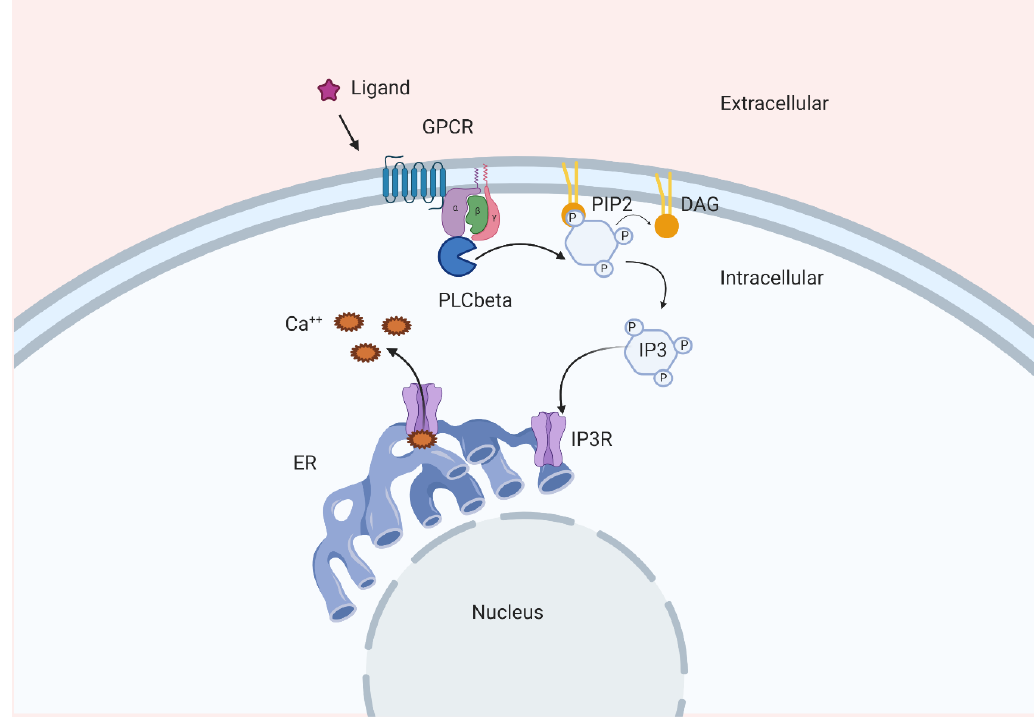
Figure 2. Schematic representation of one of the pathways involved in Ins(1,4,5)P 3 -dependent Ca 2+ release. GPCR, G protein-coupled receptor; IP3, Ins(1,4,5) P 3 ; Ca ++ , calcium; ER, endoplasmic reticulum; IP3R, Ins(1,4,5) P 3 receptor; DAG, diacylglycerol; PIP2, PtdIns(4,5) P 2 .